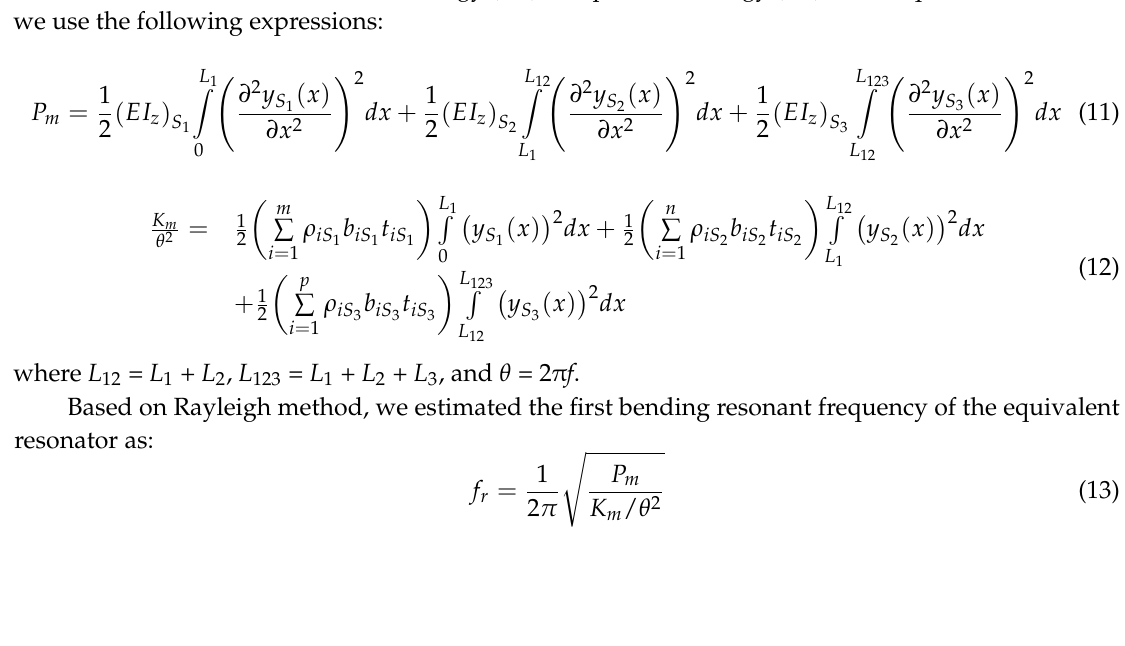
Figure 5. View of the nomenclature used to determine the elastic centroid ( a sj ) of the j th cross-section